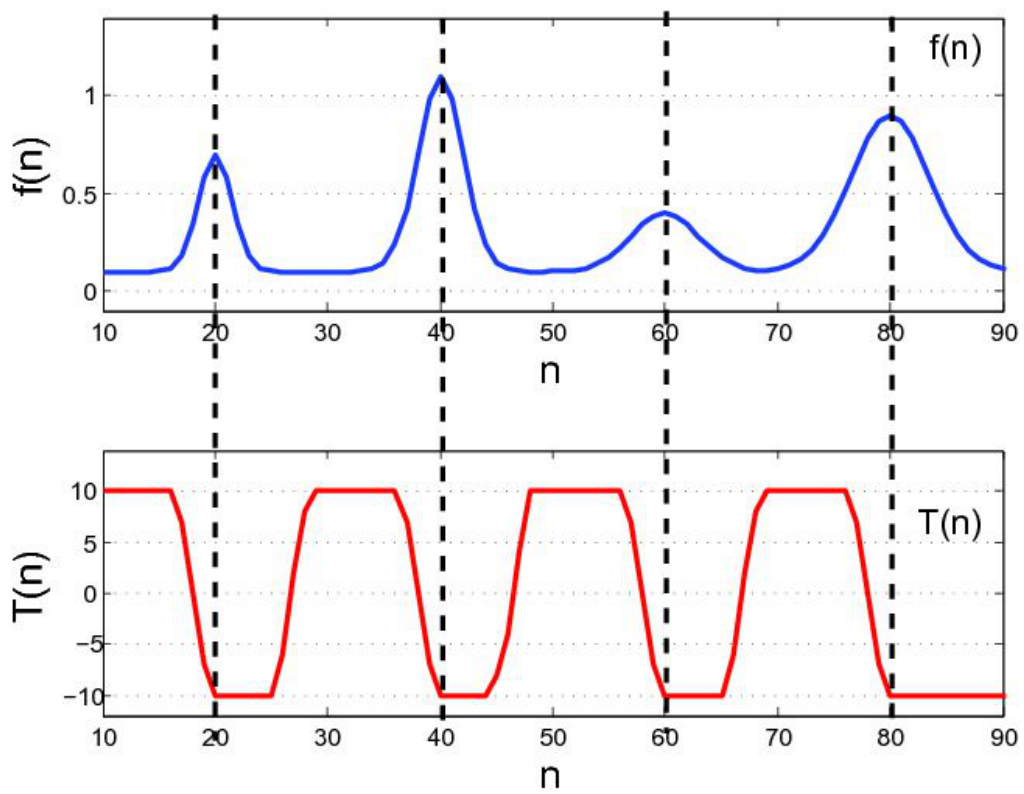
Figure 4. Robustness of local trend. Four peaks in f ( n ) conform to Gaussian distribution and have different arguments (stripe width and amplitude), but local trend T has the same max-to-min transition pattern at each peak